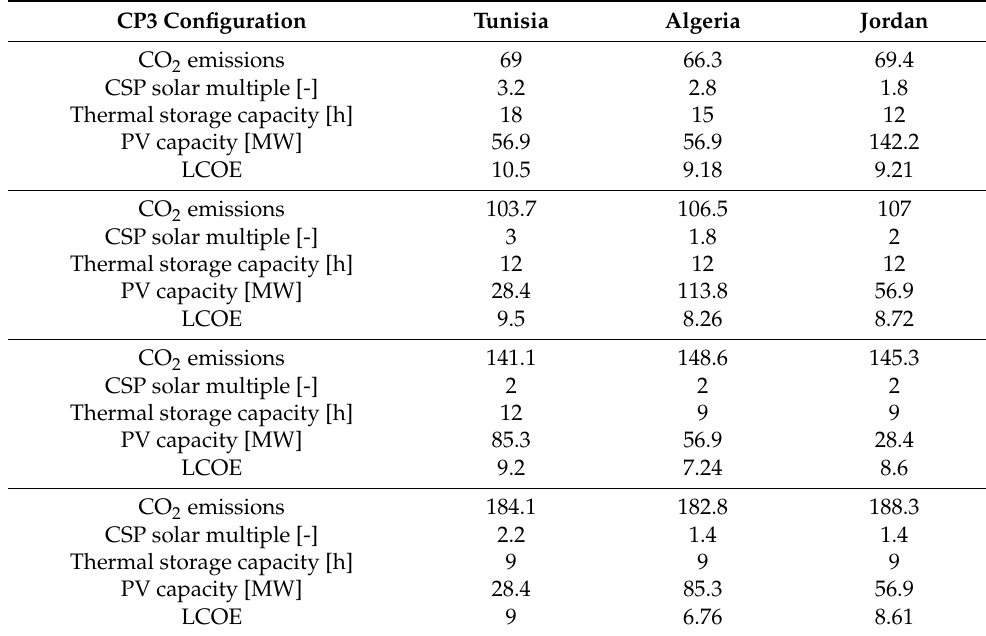
Table 8. Key results of LCOE optimization for CP3